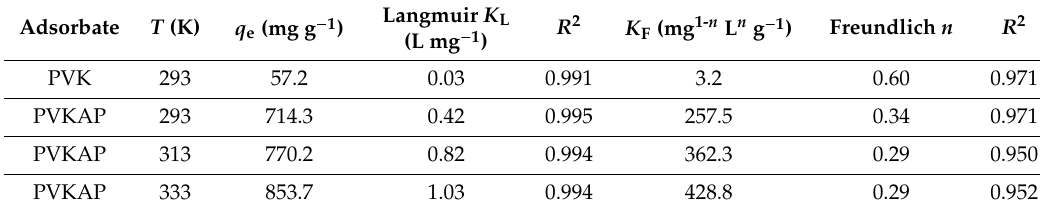
Figure 4. ( a ) Experimental equilibrium adsorption data of PVK and PVKAP under the condition of m / V = 0.1 g L − 1 , C U(VI)initial = 12.8~79.4 mg L − 1 , pH = 5 and 293 K; ( b ) adsorption isotherms of Langmuir (solid line) and Freundlich (dash line) for PVKAP capturing (VI) under di ff erent temperatures; ( c ) e ff ect of temperature on the U (VI) captured by PVKAP; ( d ) variation of ln K d with T − 1 . Table 2. Isotherms parameters of Langmuir and Freundlich for PVK and PVKAP.